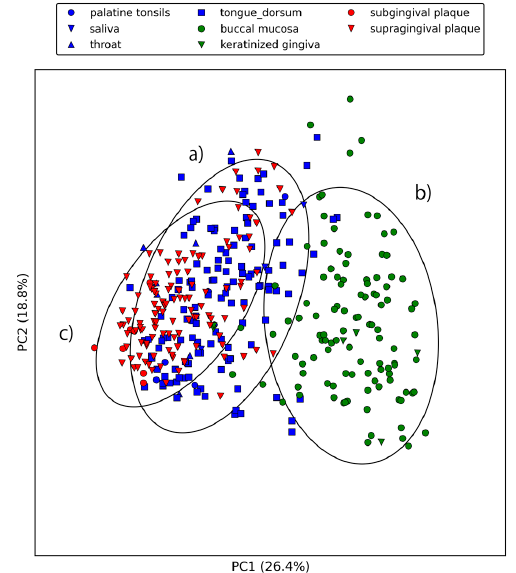
Figure 3. First and second principal components of the relative abundances of orthologous groups. Ellipses represent the covariance (2 σ ) of the three oral site groups. ( a ) indicates oral cavity (palatine tonsils, saliva, throat, and tongue dorsum), ( b ) indicates oral vestibule (buccal mucosa and keratinized gingiva), and ( c ) indicates plaque (subgingival plaque and supragingival plaque).